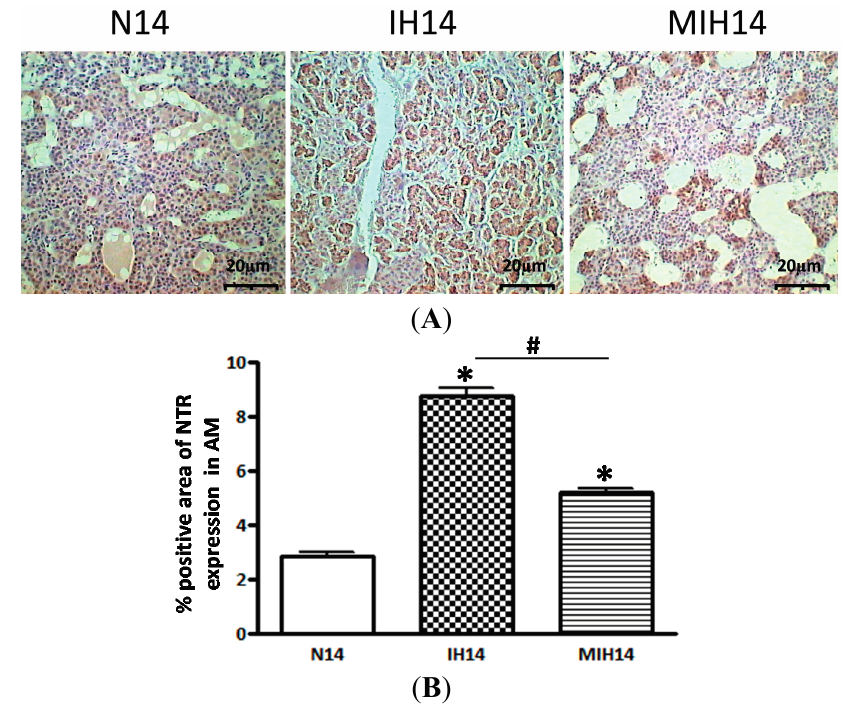
Figure 2. Immunostaining of nitrotyrosine (NTR) in the adrenal medulla of hypoxic rats and controls. ( A ) The positive-immunoreactivity of NTR was significantly increased in the hypoxic groups (IH and MIH group) than the Nx, but it was attenuated by the melatonin treatment (MIH group); and ( B ) Data are presented in % area with positive staining of NTR immunoreactivity. (* p < 0.05, versus normoxic control; # p < 0.05, versus IH group. n = 6 per group). Nx, normoxic control; IH, intermittent hypoxia; MIH, melatonin-treated intermittent